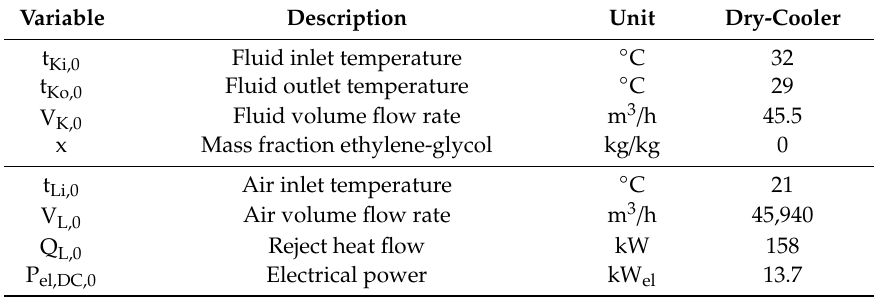
Table 2. Nominal values of the reject heat device in dry-cooler mode at the Federal Environment Agency (UBA) in Dessau,